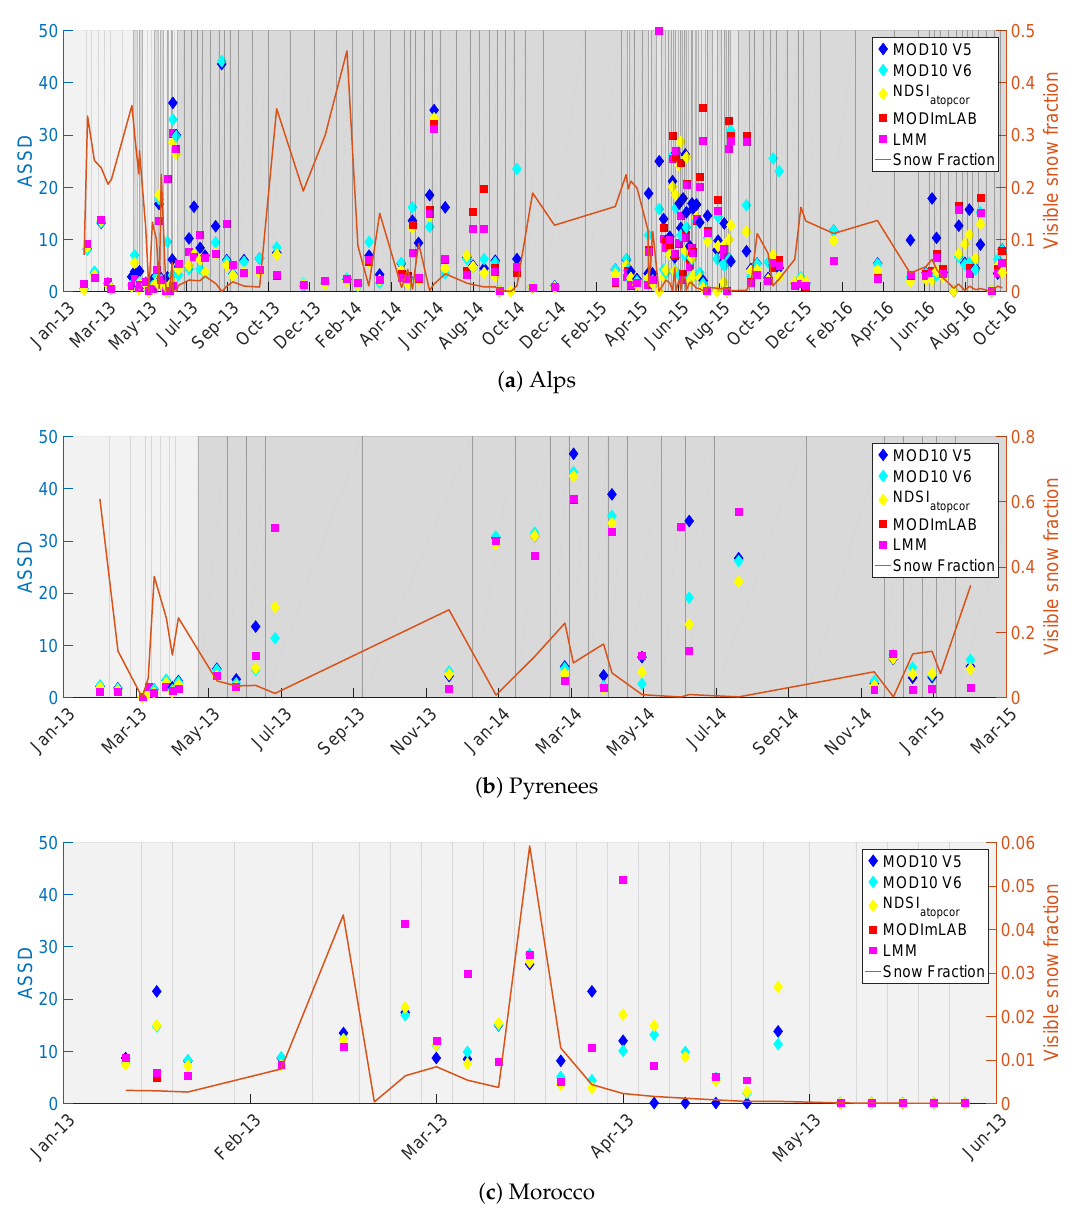
Figure 5. Average symmetric surface distance (ASSD) of the snow line at 50% threshold (markers) and global snow cover fraction (orange line) for the Alps ( a ), Pyrenees ( b ), and Moroccan Atlas ( c ) as a function of available dates in each area. The most recent dates could not be plotted for Morocco due to the SCA being too low. Square markers correspond to SU approaches and diamond-shaped markers to the NDSI approaches. The color of the background corresponds to the sensor used as reference. The lighter grey represents SPOT 4, the medium grey SPOT 5, and the darker grey